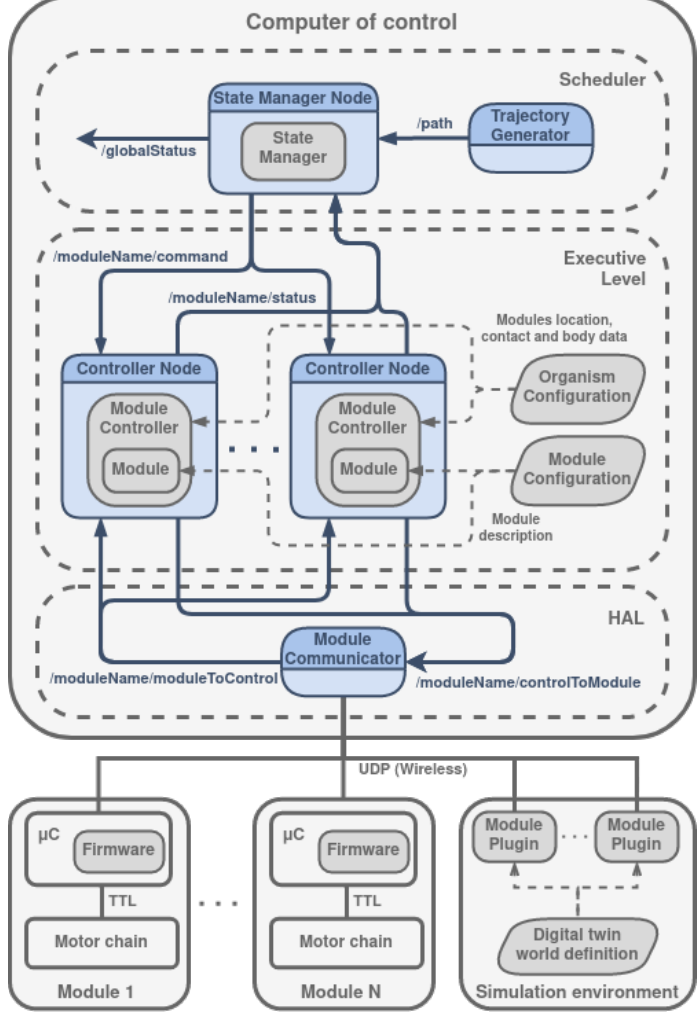
Figure 5. MoCLORA architecture. Rounded rectangles represent hardware devices, while dashed ones represent architecture levels. The dark gray boxes represent C++ objects. Parallelograms are configuration files. The blue containers are ROS2 nodes that use the objects to execute a routine. Gray lines represent inter-device communication, blue ones ROS2 topics for messages exchange (from publisher to subscriber), and dashed ones represent the use of a